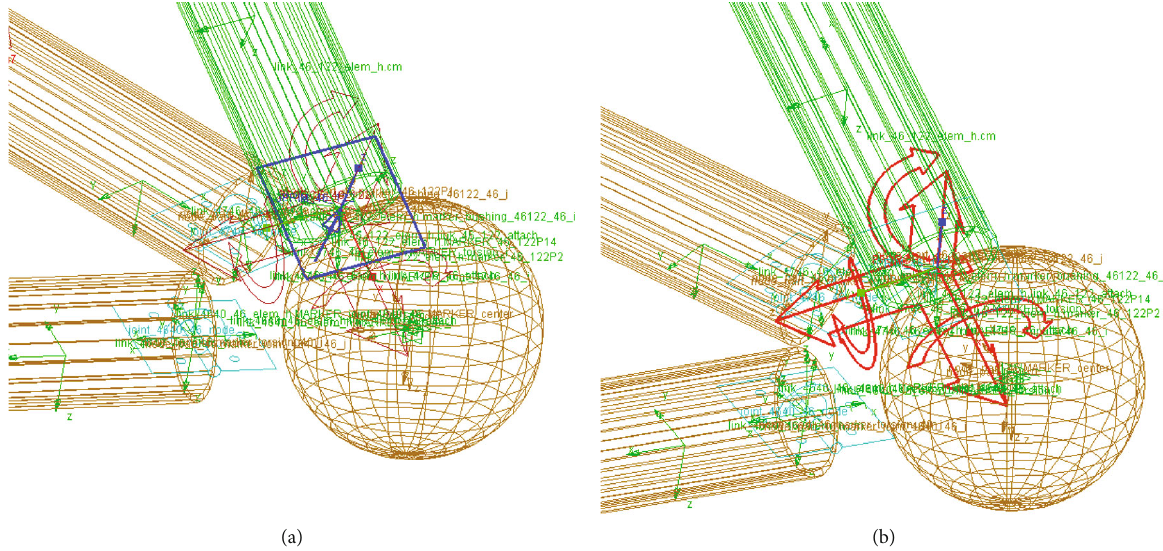
Figure 7: Modeling of connection between disk and web. (a) Inline Primitive Joint. (b) BISTOP force function. XZ Data acquisition equipment